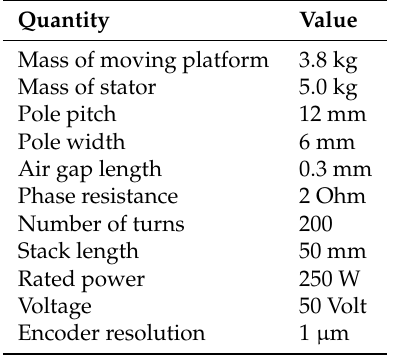
Figure 2. ( a ) machine structure and ( b ) picture. Table 1. Main Specifiations of